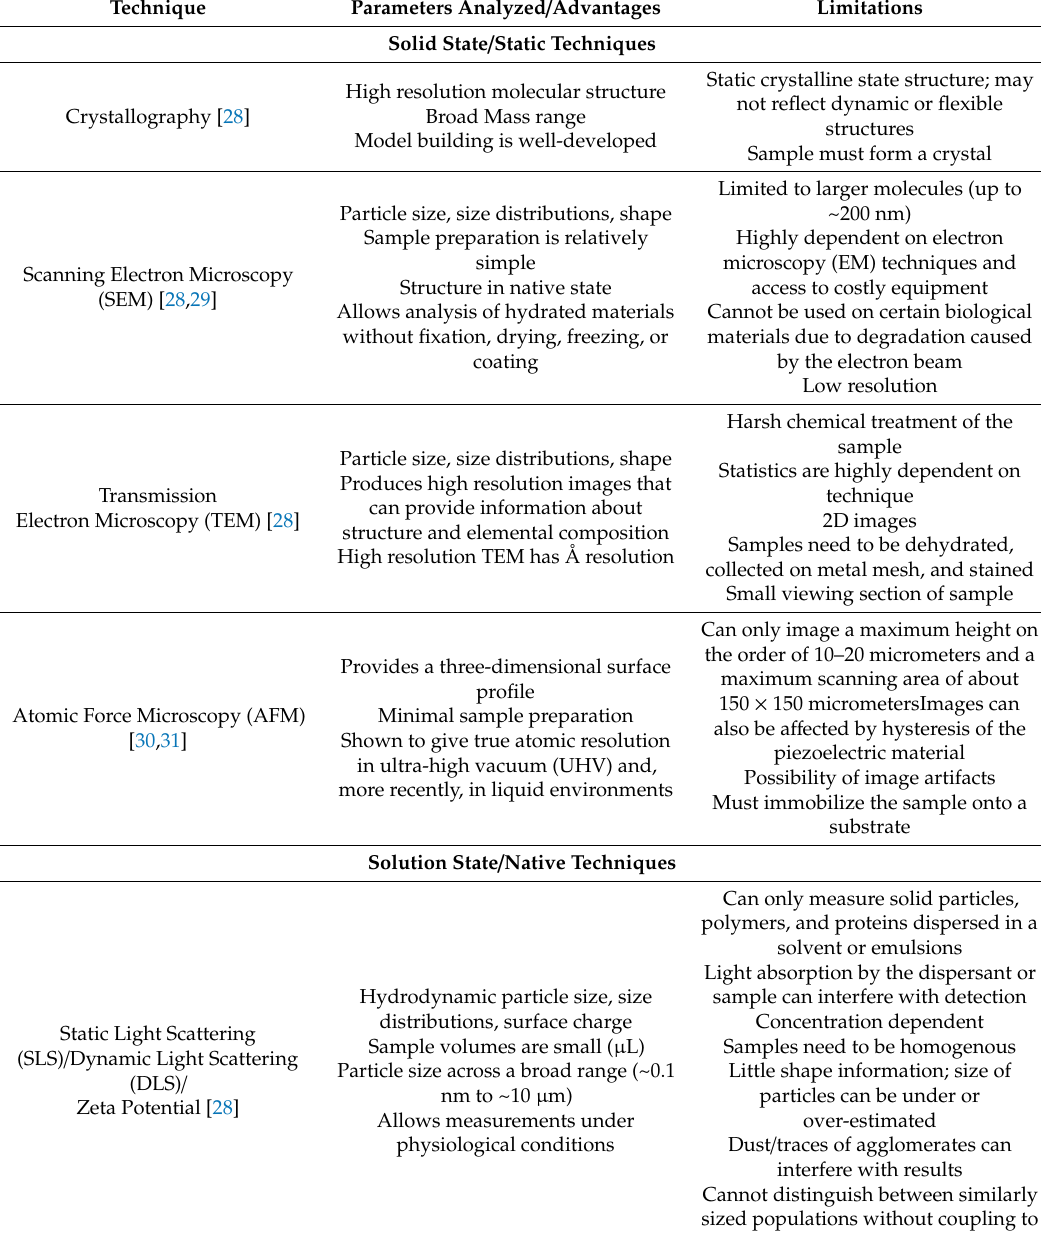
Table 1. Comparison of nanoparticle structural characterization